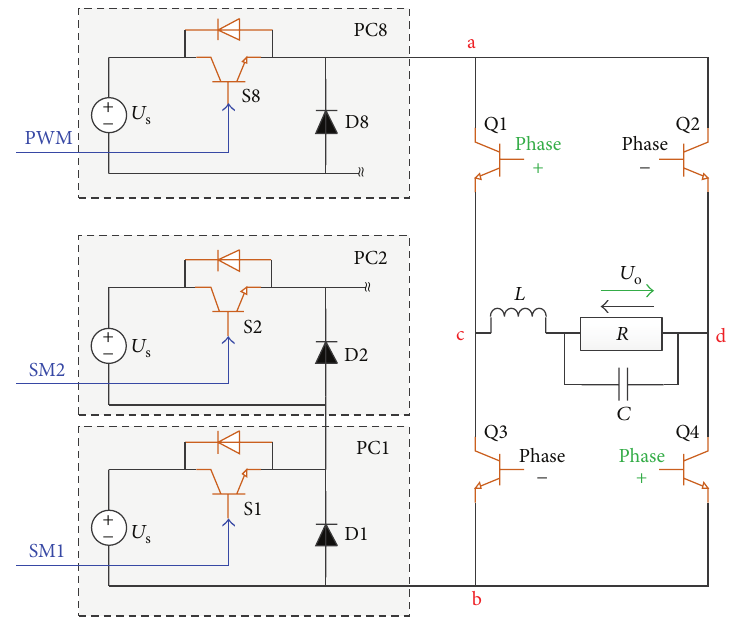
Figure 3: Schematic of hybrid multilevel